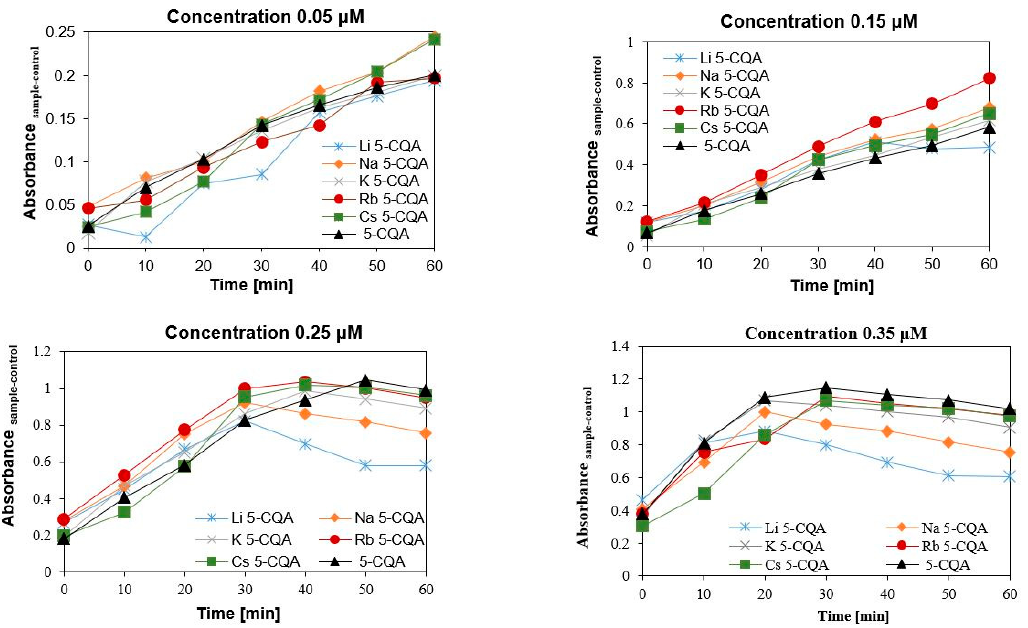
Figure 4. Comparison of the effect of the studied compounds at the concentration range 0.05–0.35 μ M on the oxidation of trolox.